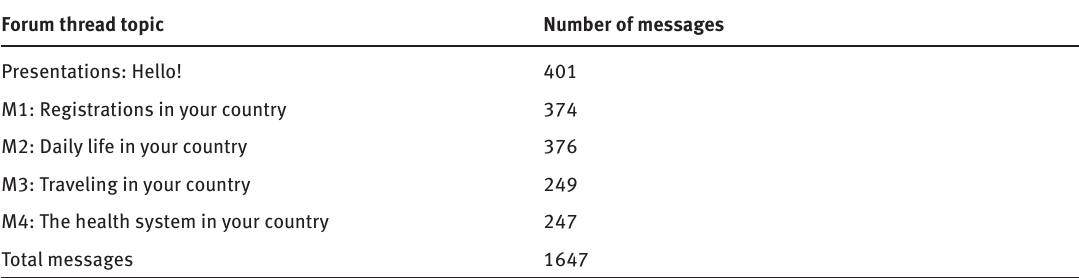
Table 3: Messages in the forum threads of Open Doors I Forum thread